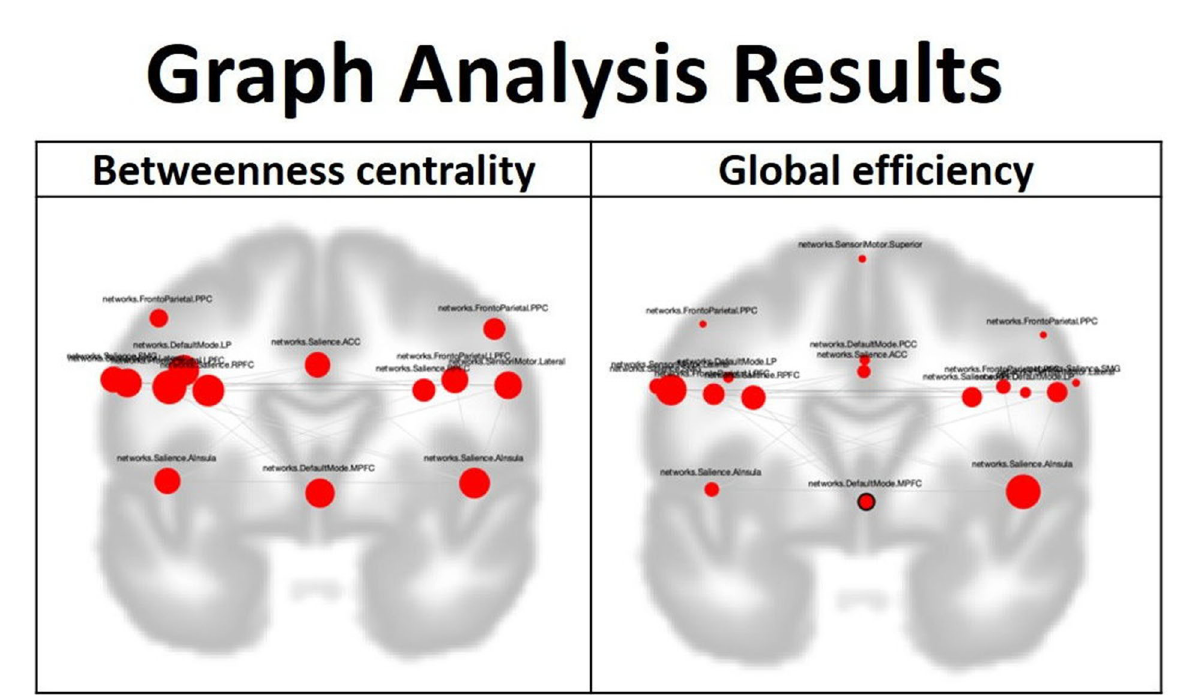
FIGURE3 In the graph analysis for the blight light therapy experimental group, after the treatment, betweenness centrality is enhanced over many nodes in the default mode network, frontoparietal network, salience network and sensorimotor network. Furthermore, global efficiency is also elevated between many nodes in these four networks and the four networks as a whole. The involved nodes in the betweenness centrality included the following: Default mode network: LP (L), left lateral parietal cortex; MPFC, medial prefrontal cortex. Salience Network: RPFC (L), The left lateral rostral prefrontal cortex; RPFC (R), The right lateral rostral prefrontal cortex; ACC, Anterior cingulate cortex; SMG (L), The left supramarginal gyrus; AInsula (L), The left anterior insula; AInsula (R), The right anterior insula. Sensorimotor network: lateral (L), left lateral region in the sensorimotor network; lateral (R), right lateral region in the sensorimotor network. Frontoparietal network: PPC (L), The left posterior parietal cortex; PPC (R), The right posterior parietal cortex; LPFC (L), The left lateral prefrontal cortex; LPFC (R), The right lateral prefrontal cortex. The involved nodes in the global efficiency included the following: Default mode network: PCC, posterior cingulate cortex; LP (L), left lateral parietal cortex; MPFC, medial prefrontal cortex; LP (R), right lateral parietal cortex. Salience Network: RPFC (L), The left lateral rostral prefrontal cortex; RPFC (R), The right lateral rostral prefrontal cortex; ACC, Anterior cingulate cortex; SMG (L), The left supramarginal gyrus; SMG (R), The right supramarginal gyrus; AInsula (L), The left anterior insula; AInsula (R), The right anterior insula. Sensorimotor Network: Lateral (L), The left lateral region in sensorimotor network; Lateral (R), The right lateral region in sensorimotor network; Superior, Superior region in sensorimotor network. Frontoparietal network: PPC (L), The left posterior parietal cortex; PPC (R), The right posterior parietal cortex; LPFC (L), The left lateral prefrontal cortex; LPFC (R), The right lateral prefrontal